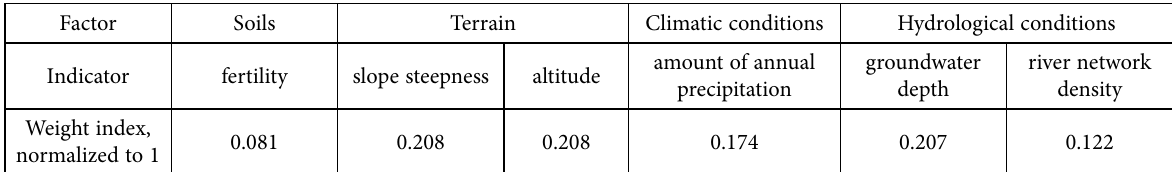
Table 1. Weights of factors and indicators of natural agricultural zoning for the areas of Polyssya and Forest Steppe Factor Soils Terrain Cli matic con di tions Hydro logical conditions Indi cator ferti lity slope steep ness Weight